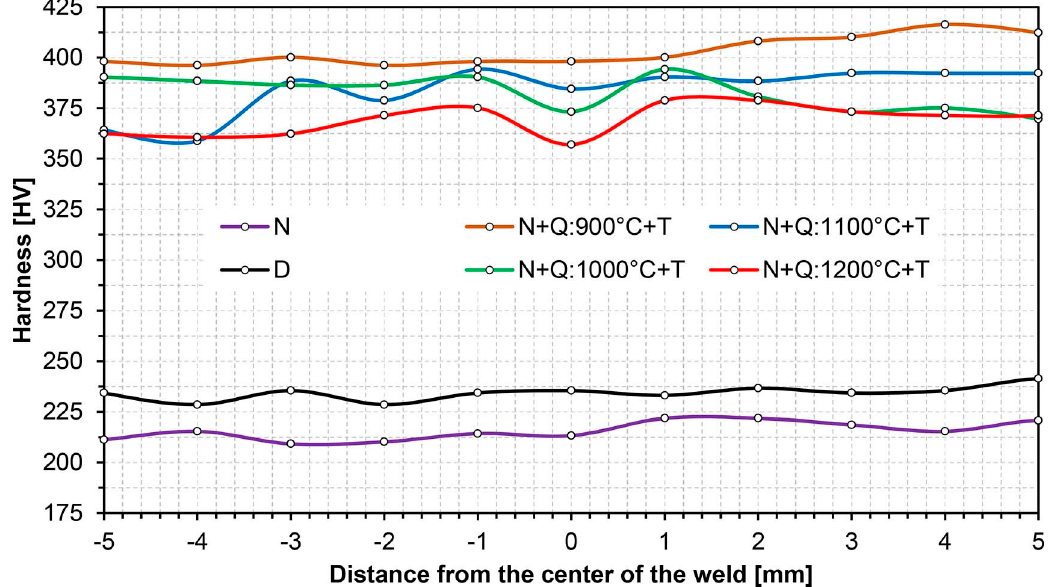
Figure 4. Hardness distributions of the welded joint of Hardox 450 along line B in Figure 1: D—delivery state (directly after welding), N—normalised state, Q—quenched state, T—tempering.